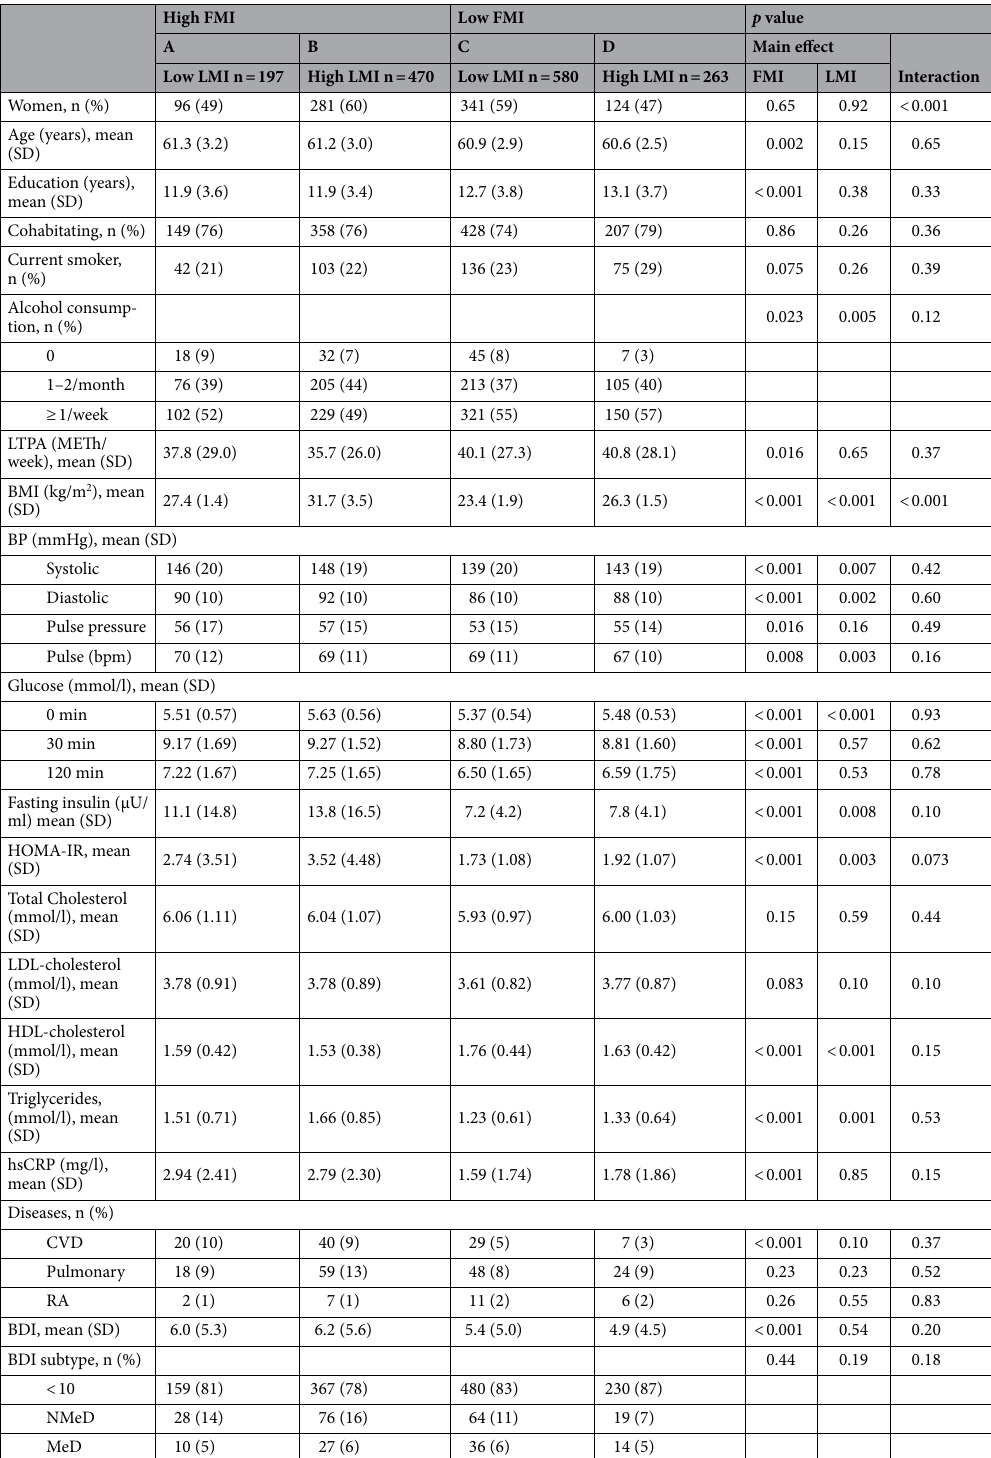
Table 1. Characteristics of participants by group. Disease subgroups: CVD : angina pectoris, myocardial infarction, stroke; Pulmonary : asthma, chronic obstructive pulmonary disease. BDI beck depression